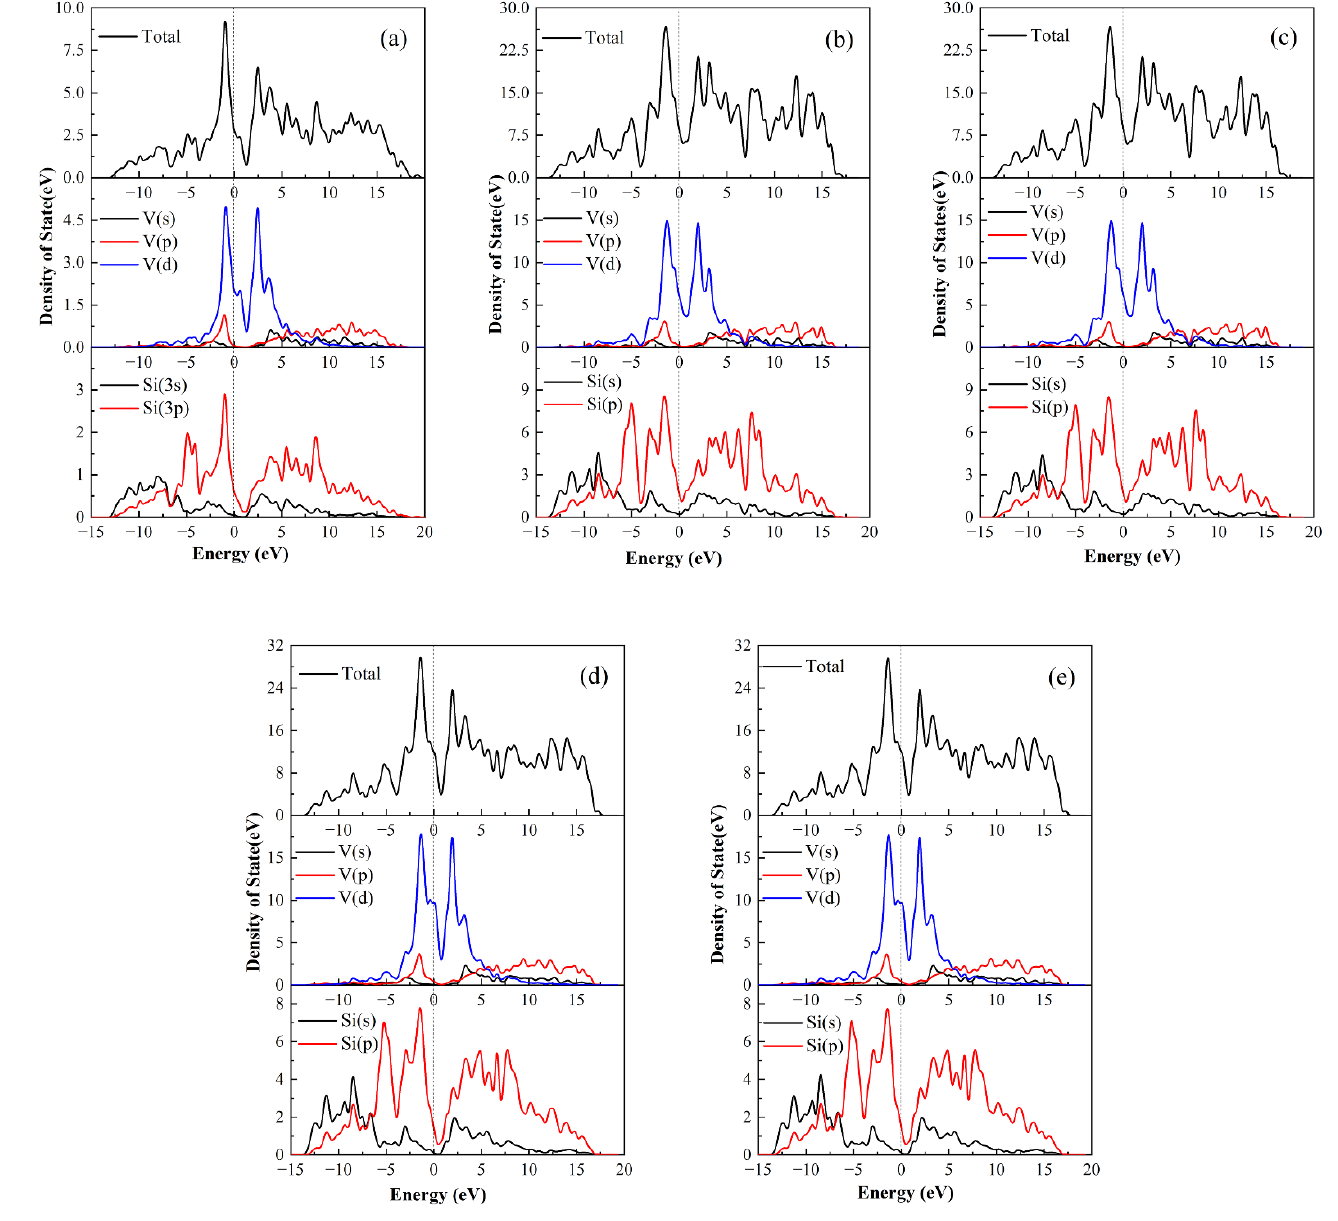
Figure 7. Total and partial density of states for C11 b -VSi 2 with different vacancies, ( a ) C11 b -VSi 2 , ( b ) V-va1, ( c ) V-va2, ( d ) Si-va1, and ( e ) Si-va2, respectively.